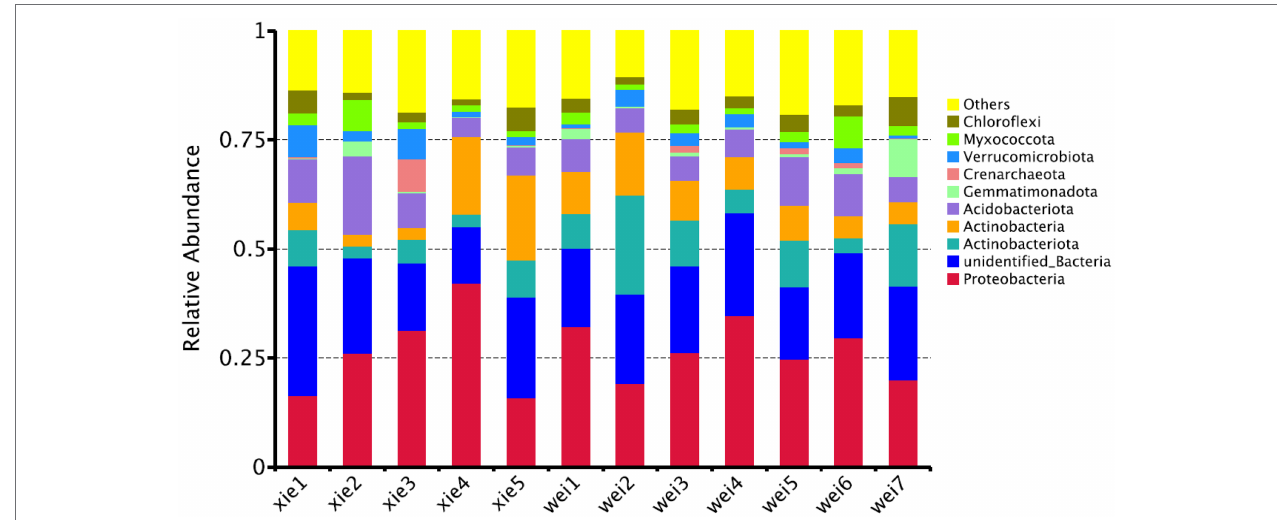
FIGURE 6 | The relative abundance of the bacterial communities at the phylum taxon level by high-throughput sequencing (HTS)-based analysis. “xie1–xie5” and “wei1–wei7” indicate soil samples from Xieyang and the Weizhou Islands, respectively.